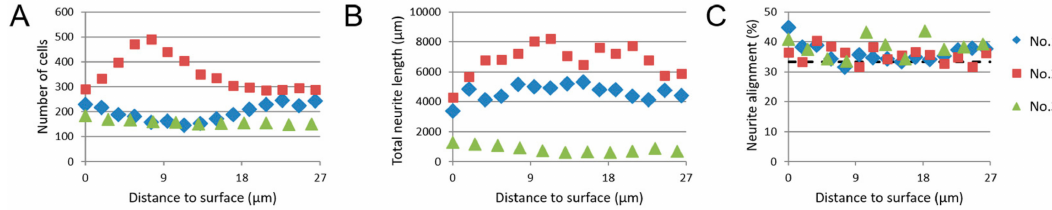
Figure 8. Results from analysis of 3D SH-SY5Y cell cultures on nanogrooved substrates. ( A ) The number of cells, ( B ) the total outgrowth length ( µ m) and ( C ) outgrowth alignment (%) relative to the distance ( µ m) away from the nanogrooved substrate. The dashed line at 33% alignment in ( C ) represents an isotropic distribution of outgrowths without preferred direction. For visibility of the data points, the alignment axis was capped at 50% instead of 100% alignment. The legend to the right of ( C ) describes the samples as shown in ( A – C